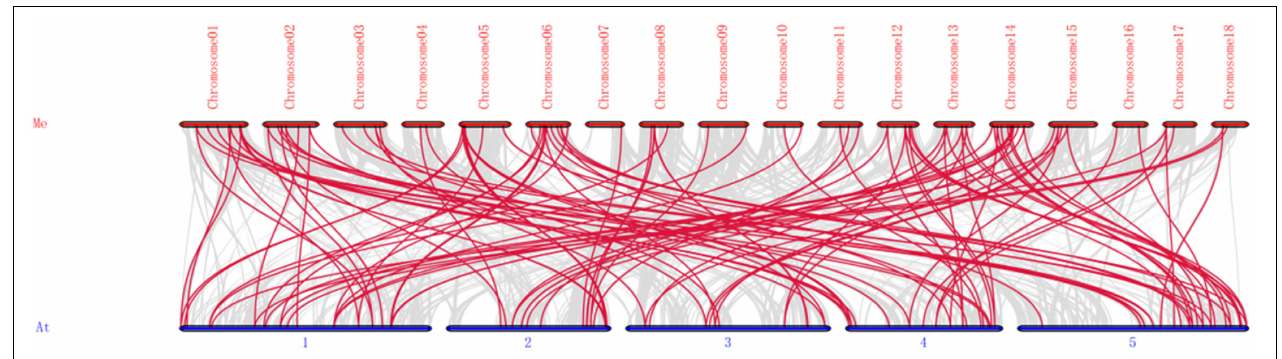
FIGURE 4 | Synteny analysis of bHLH genes between M. esculenta and A. thaliana. Me indicates M. esculenta , At indicates A. thaliana . Gray lines in the background represent the collinear blocks within the genomes of M. esculenta and A. thaliana , while the red lines show the collinear bHLH gene pairs.